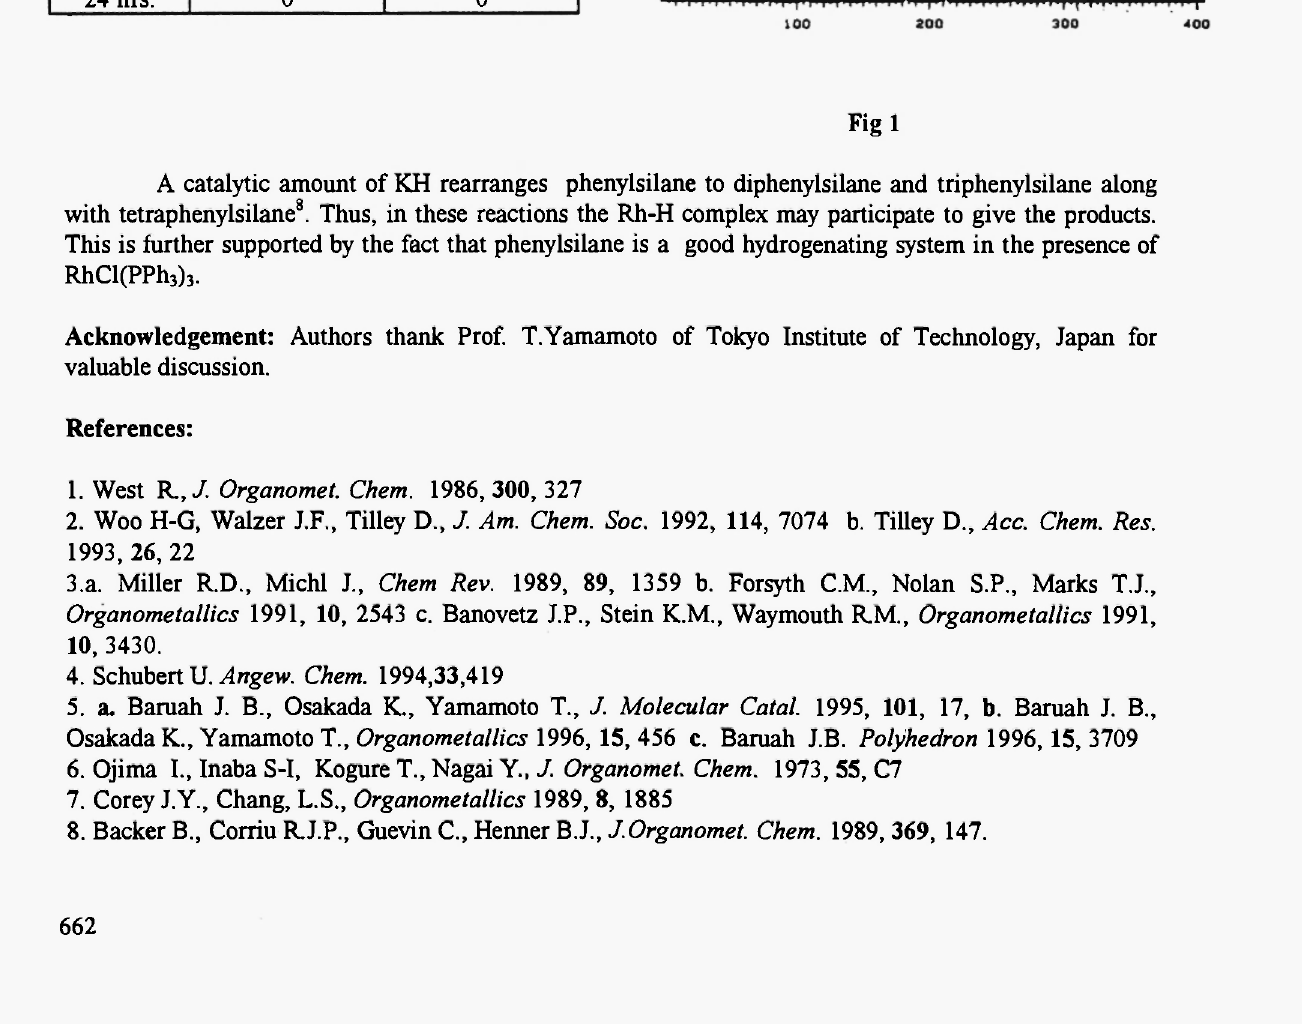
Ratio of phenylsilane and diphenyl silane in the reaction of phenylsilane with RhCl(PPh ) 3 3 Time in Ratio PhSiH 3 / Ratio PhSiH 3 / hrs. Ph SiH under Ph SiH under 2 2 2 2 aerobic anaerobic condition condition 1.5 hrs 3 0.89 2.5 hrs 1.33 0.33 0.67 0.033 24 hrs.